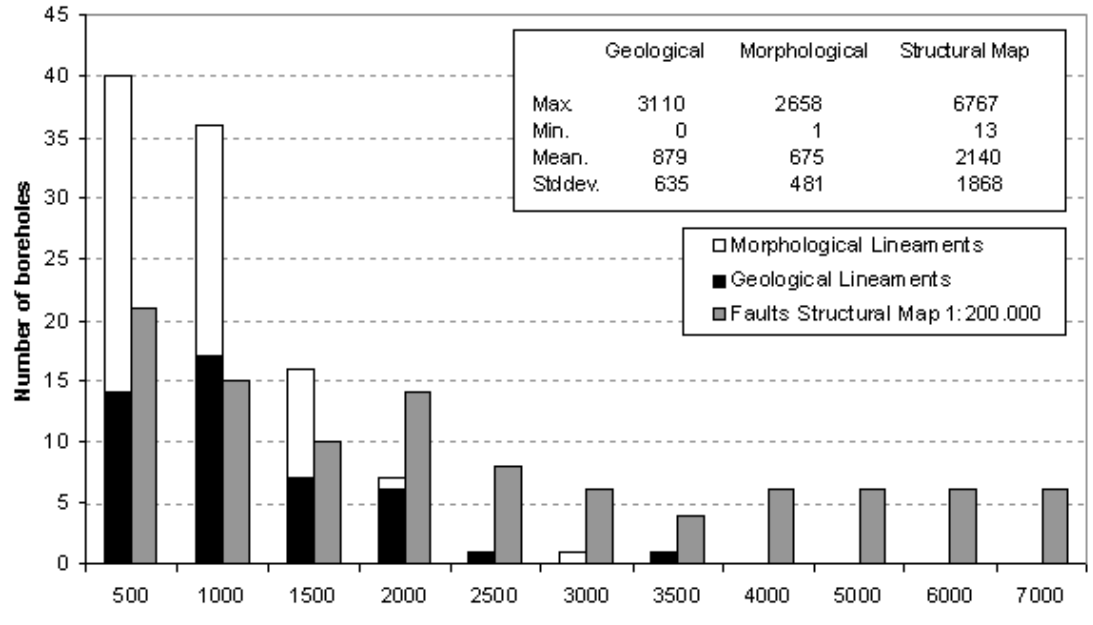
Table 3. Comparison of Euclidean distances from wells towards the nearest feature (differentiated lineaments and faults contained in the structural map